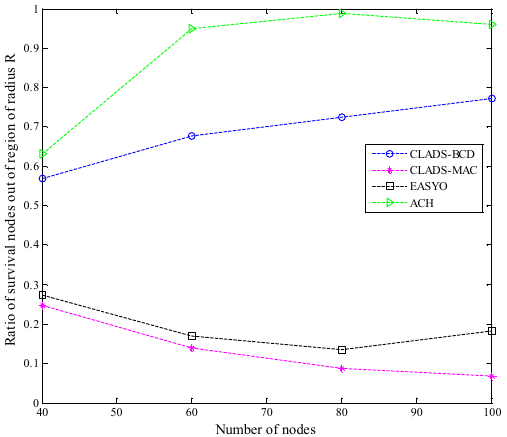
Figure 4. Comparison of the ratio of survival nodes out of region of radius